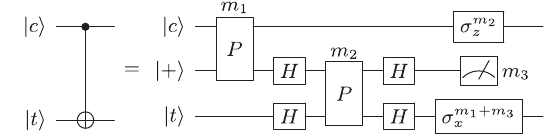
FIG. 4. Quantum circuit for a CNOT gate using parity measure- ments and an ancilla qubit initialized in the jþi state. First, the ⊗ σ parity operator σ of the control and ancilla is measured, z z ⊗ σ with outcome m 1 . Next, the parity operator σ of the ancilla x x and target is measured, with outcome m 2 . Finally, the ancilla is measured in the computational basis σ with outcome m 3 . The z three outcomes determine the final correctional operation σ m 2 z ⊗ σ m 1 þ m 3 x on the control and target, which can also be done by updating the Pauli frame.